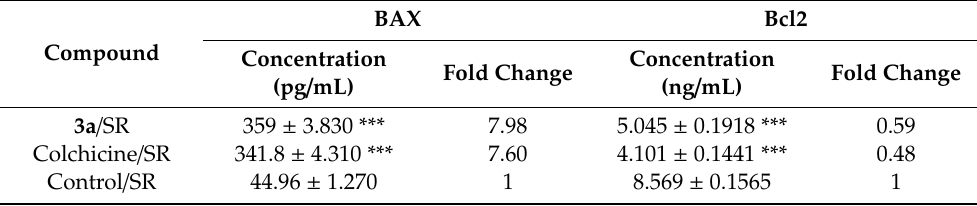
Table 8. Bax and Bcl-2 conc ± SD and fold change levels for compounds 3a and colchicine on leukemia SR cell